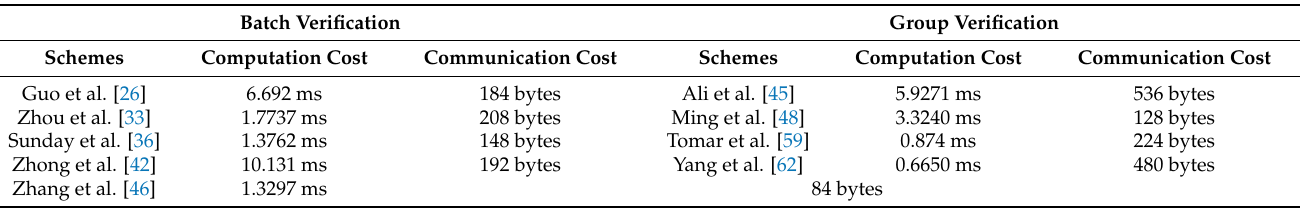
Table 15. Performance comparison of batch verification vs group signature verification schemes based on communication and communication costs.